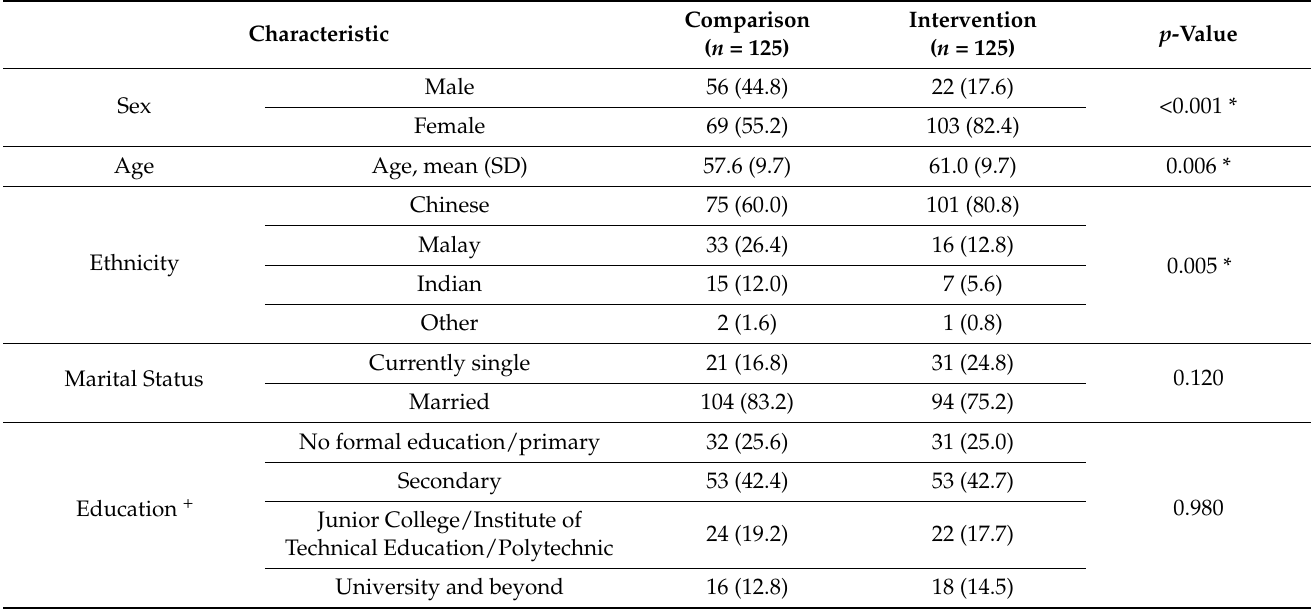
Figure 1. Consort Flow Diagram. Table 1. Comparison of sociodemographic characteristics and the primary outcome for intervention and comparison groups at